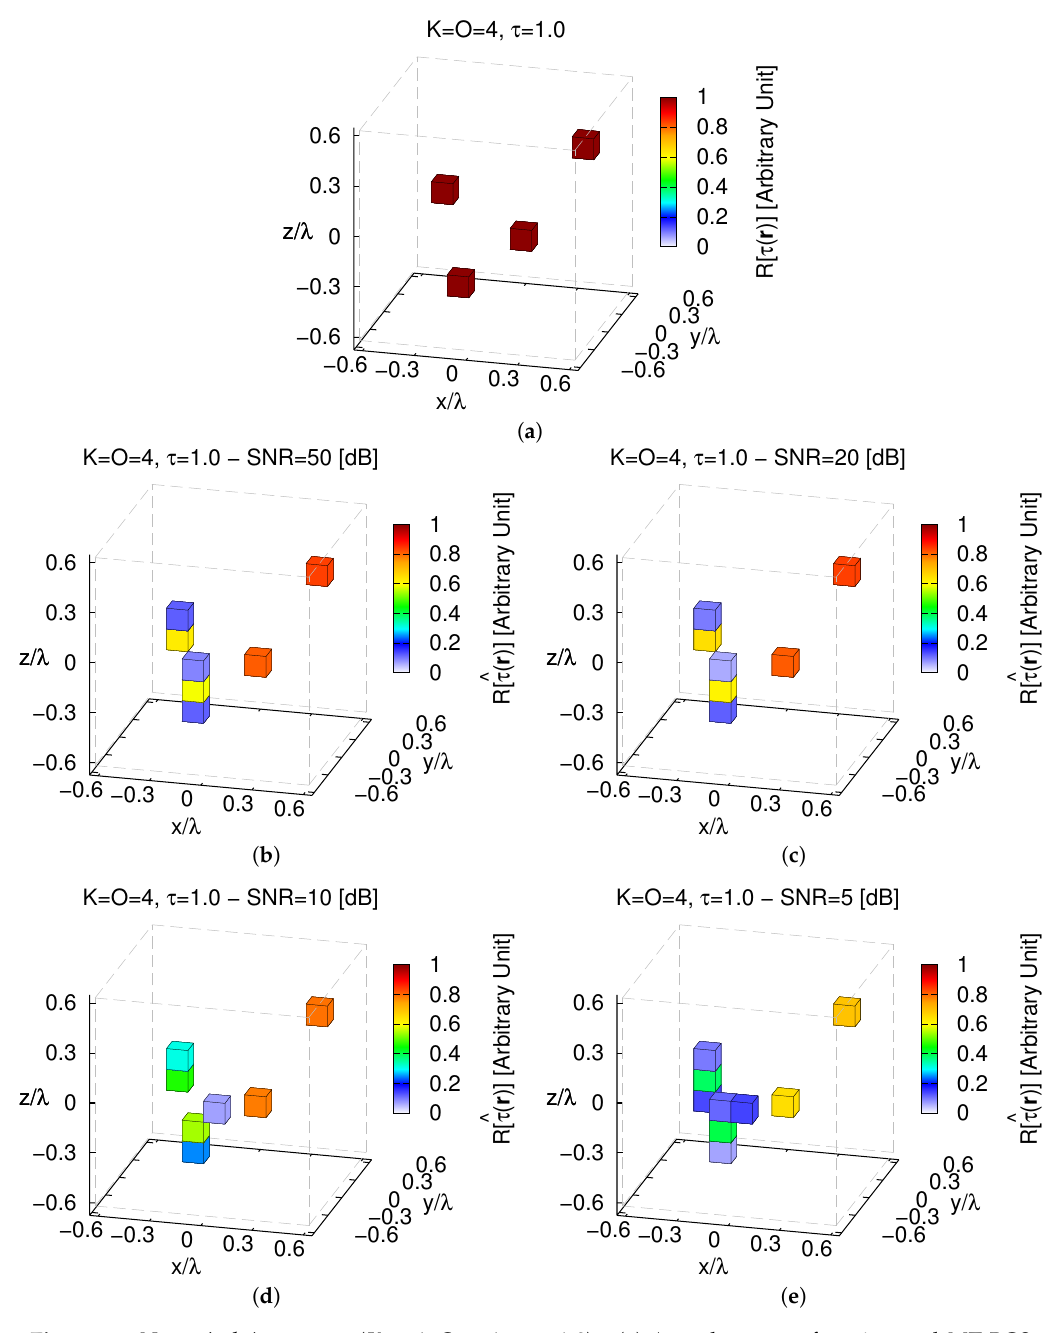
Figure 10. Numerical Assessment ( K = 4, O = 4, τ = 1.0)—( a ) Actual contrast function and MT-BCS reconstructions when processing the scattering data characterized by ( b ) SNR = 50 [dB] ( (cid:98) τ max = 0.84), ( c ) SNR = 20 [dB] ( (cid:98) τ max = 0.84), ( d ) SNR = 10 [dB] ( (cid:98) τ max = 0.80), and ( e ) SNR = 5 [dB] ( (cid:98) τ max =